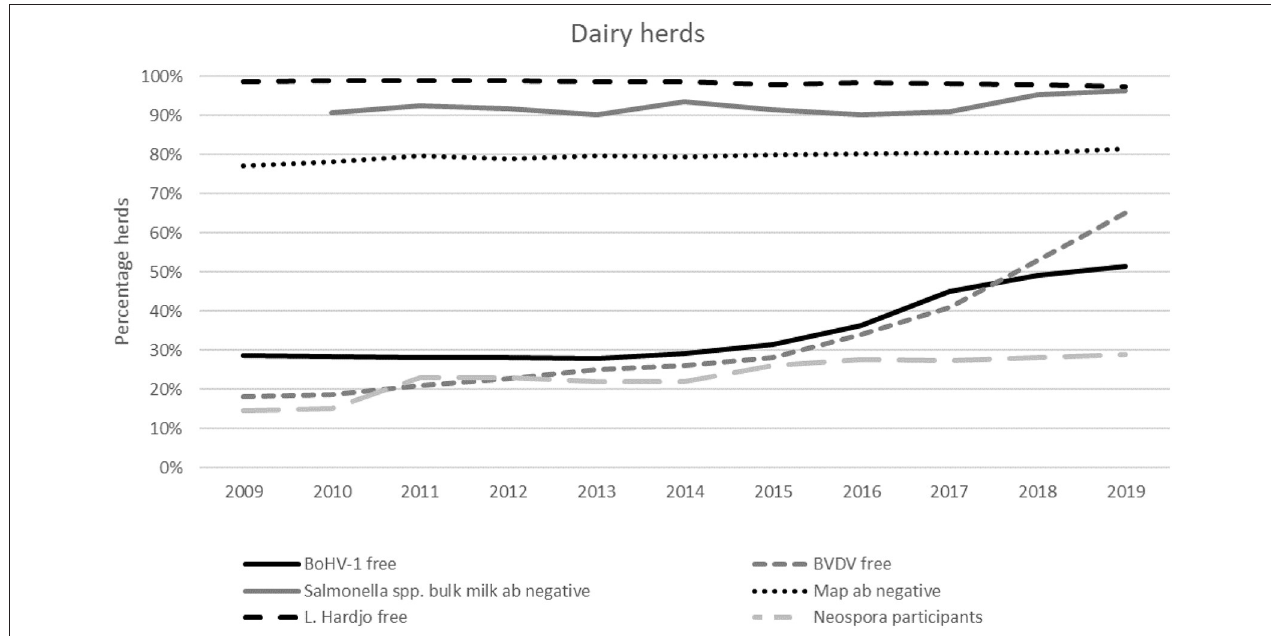
FIGURE 8 | Dutch dairy herds with a free (BVDV, BoHV-1, L . Hardjo) or unsuspected ( Salmonella spp., Map ) status, or that participate in the Neospora monitoring program between 2009 and